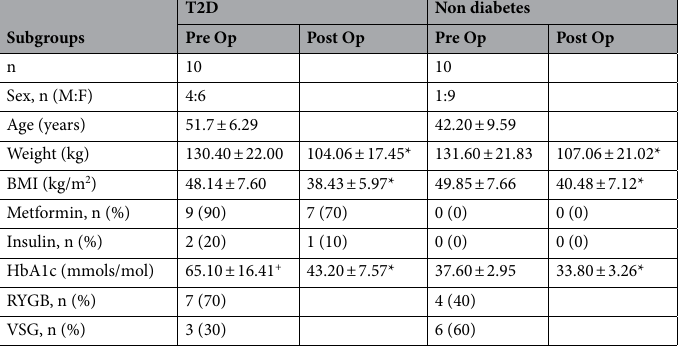
Table.3. Effect of surgery by T2D diagnosis subgroups. + Significant difference between baseline demographics. *p < 0.05 pre- and post-op